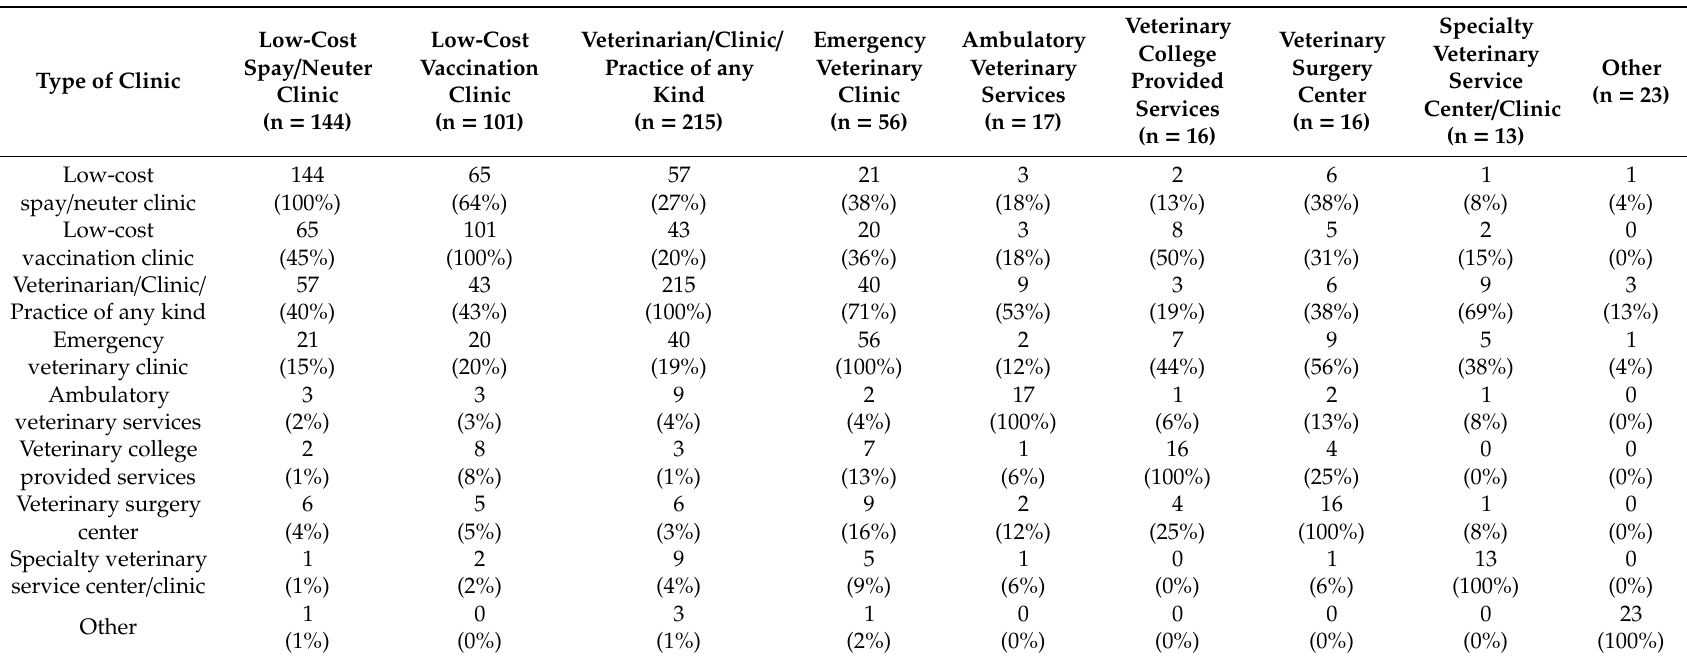
Table 5. Percentage of respondents who used multiple veterinary service options for their cat, reported number and percentage of respondents who indicated they used each type of veterinary